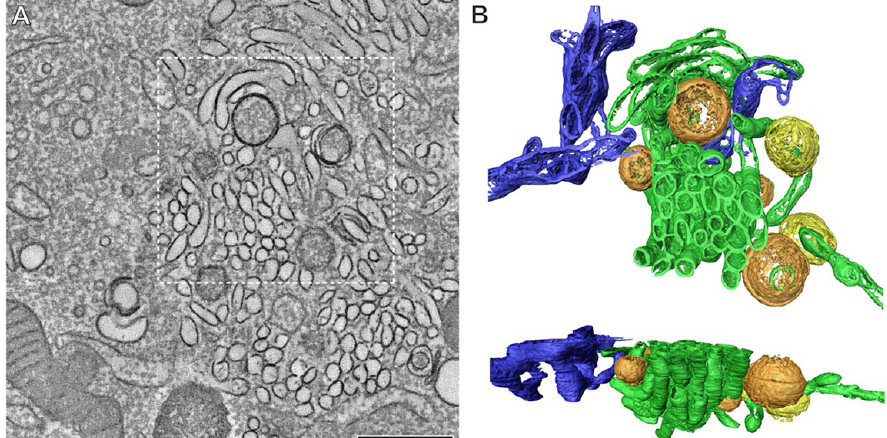
Figure 4. Extensive membrane rearrangements in Enterovirus-infected cells. An electron tomographic slice through a serial tomogram, bar = 500 nm ( A ); and top and side views of the surface-rendered model of the boxed area ( B ) show the presence of single-membrane tubules ( green ), open ( orange ) and closed ( yellow ) double-membrane vesicles in a cell infected with coxsackievirus B3 at 5 h post infection. The ER is depicted in blue. Reprinted from Limpens et al. [70], mBio 2011 with permission from the authors, © 2011 by the American Society for Microbiology.